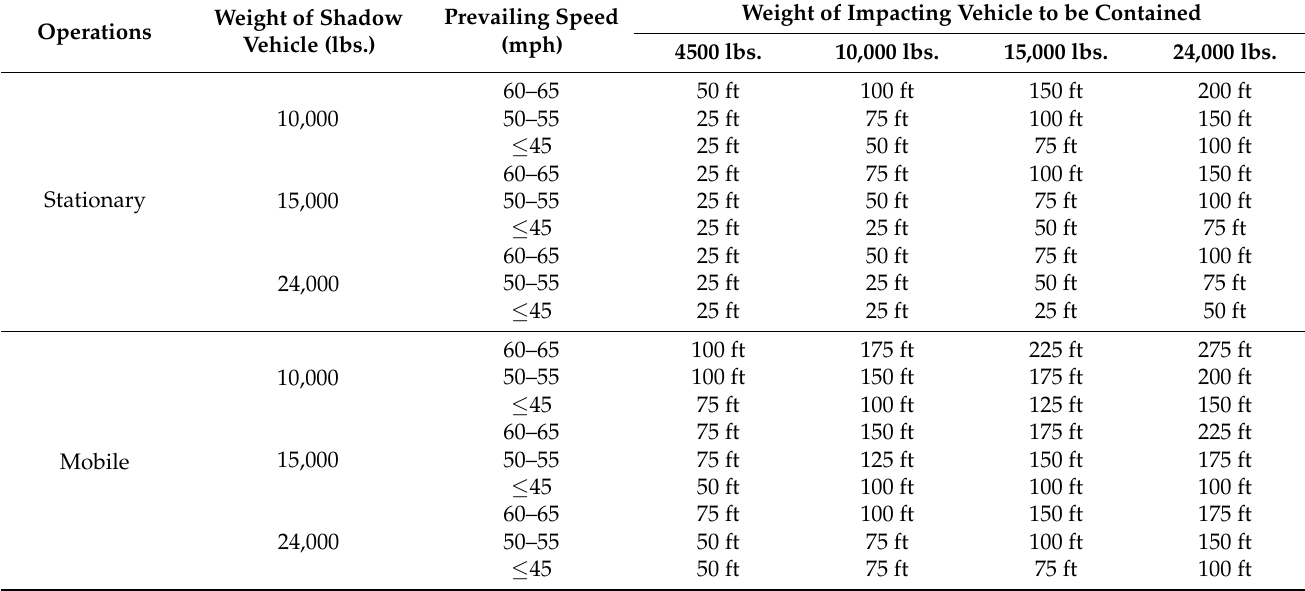
Table 13. Roll-ahead distances for stationary and mobile operations